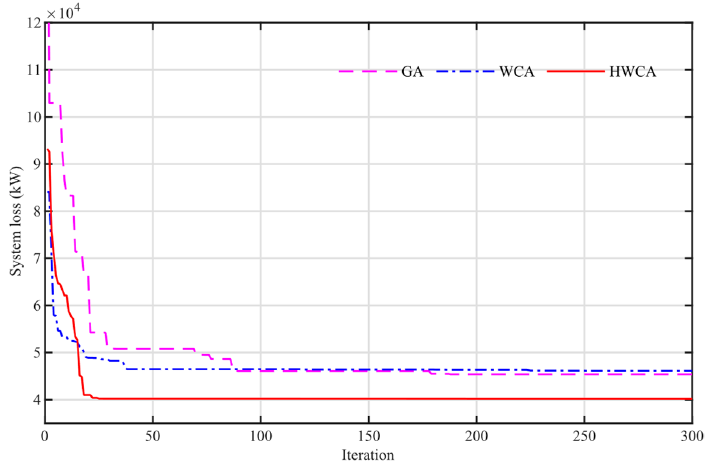
Table 6. Compared numerical results of HWCA for case 7 with WCA and GA for the 69-node sys-